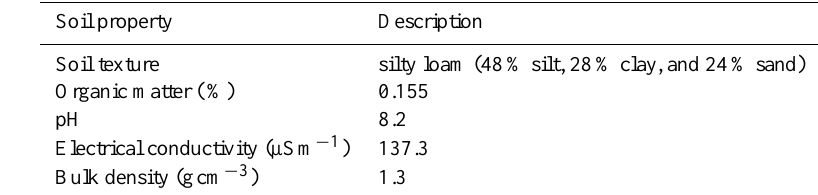
Table 1. Main original soil characteristics ( n = 3).